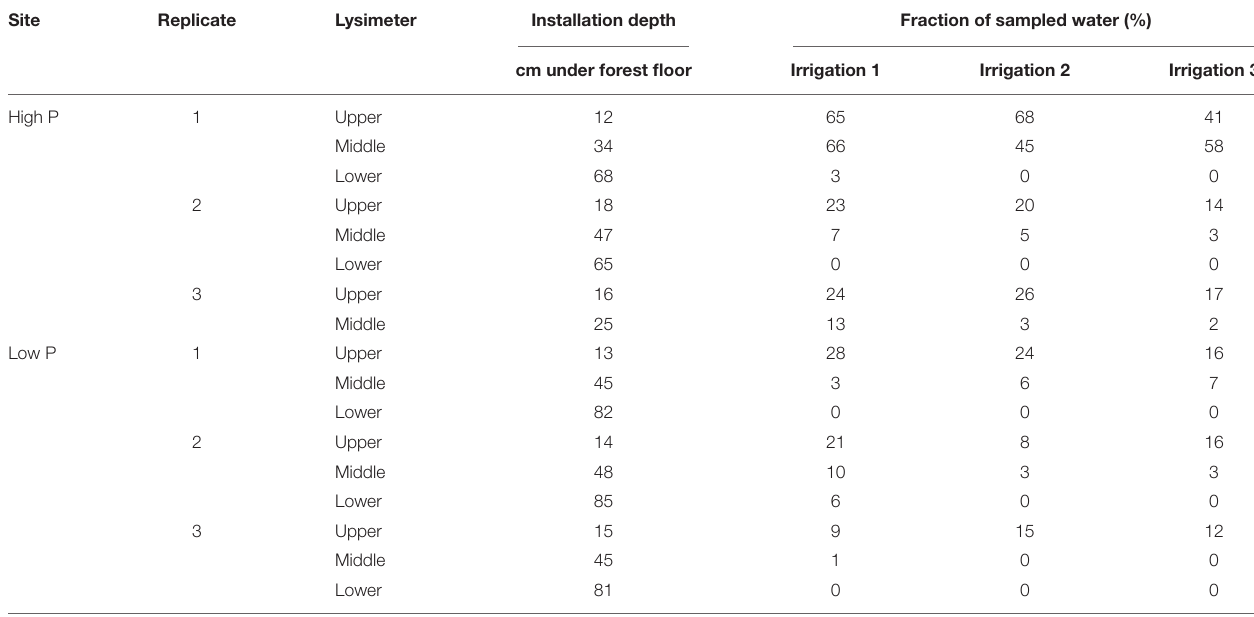
TABLE 3 | Installation depths and the fraction of sampled water of the lysimeters at the high P and low P site. Site